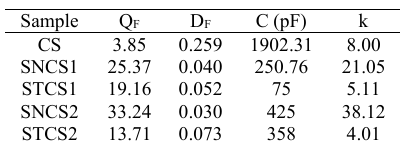
Fig. 10. Contour plots of compressive strengths versus nanomaterial interactions Table 5. Q F , D F , C and k of nanocomposites obtained by using GPS 132 A (f = 120 Hz)